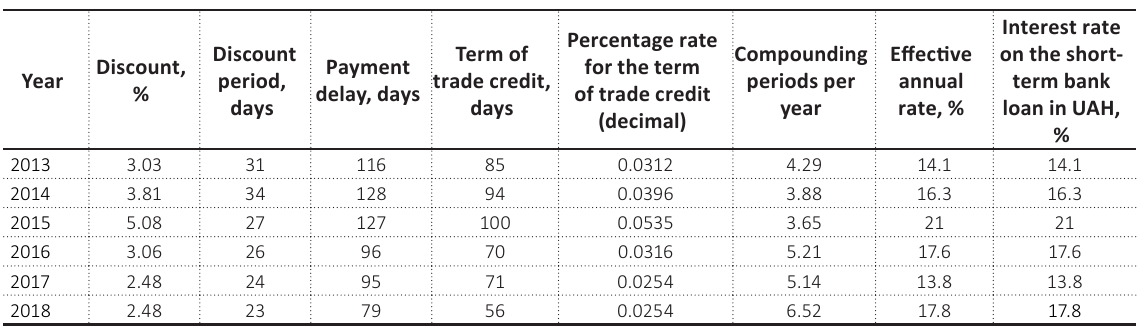
Source: Calculated by the